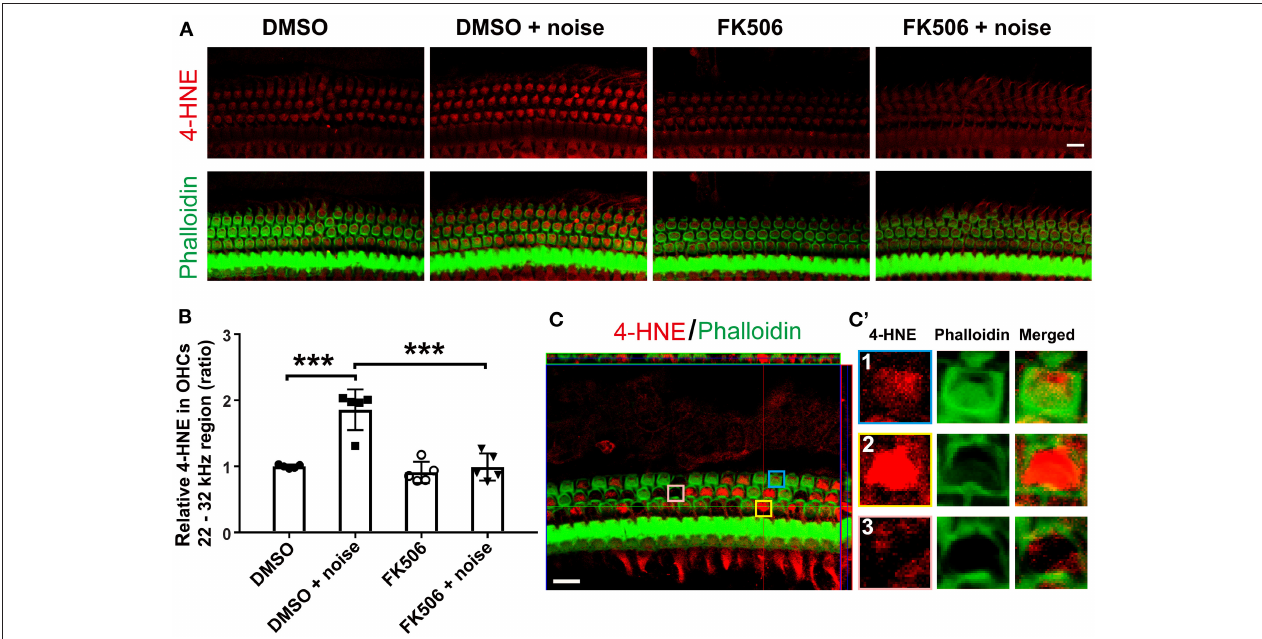
FIGURE 3 | Treatment with FK506 blocks the induction of lipid peroxidation product 4-HNE by noise. (A) Surface preparations show immunolabeling for 4-HNE (red) in outer hair cells (OHCs) assessed 3h after the completion of exposure. Noise-increased 4-HNE is inhibited by treatment with FK506. Green, phalloidin labeling of sensory hair cells. Images were taken from the basal turn corresponding to sensitivity to 22–32kHz, and each figure is representative of five individual mice for each condition. Scale bar = 10 µ m. (B) Quantification of relative 4-HNE immunolabeling intensity in grayscale in OHCs normalized to dimethyl sulfoxide control mice confirms inhibition by treatment with FK506. Data are presented as individual points with means ± SD; each condition was examined in one ear per mouse; *** p < 0.001. (C) This representative image shows very strong 4-HNE immunolabeling in structurally damaged OHCs assessed 3h after exposure. The image was taken from the lower basal turn corresponding to sensitivity to 45kHz. (C ′ ) For better visualization, three OHCs were enlarged and presented in the right panels with intact OHCs (1), structurally damaged OHCs (2), and scars of lost OHCs (3). This figure is representative of five individual animals per group. Scale bar = 10 µ